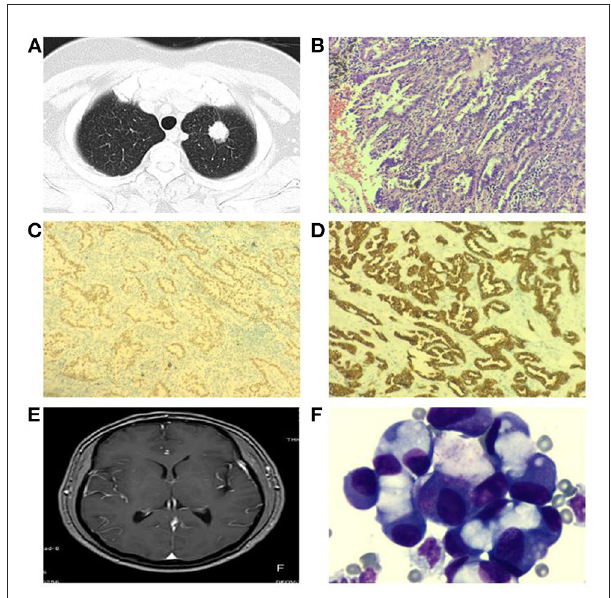
FIGURE2 Typical case shows: patient, male, 66 years old, left lung mass (A) visible at chest CT, lung cancer tissue HE staining (B) , positive expression of cytokeratin 7 (CK7) in cell membrane of lung cancer tissue (C) , positive expression of thyroid transcription factor-1 (TTF-1) in cell nucleus of lung cancer tissue (D) ; 1 year later, the patient developed headache, nausea and vomiting, no pivot meningeal enhancement was seen in the head MRI enhancement (E) , CSF cytology showed a large number of tumor cells (F) [ (B–D) :200 × ; (F) :1000 ×